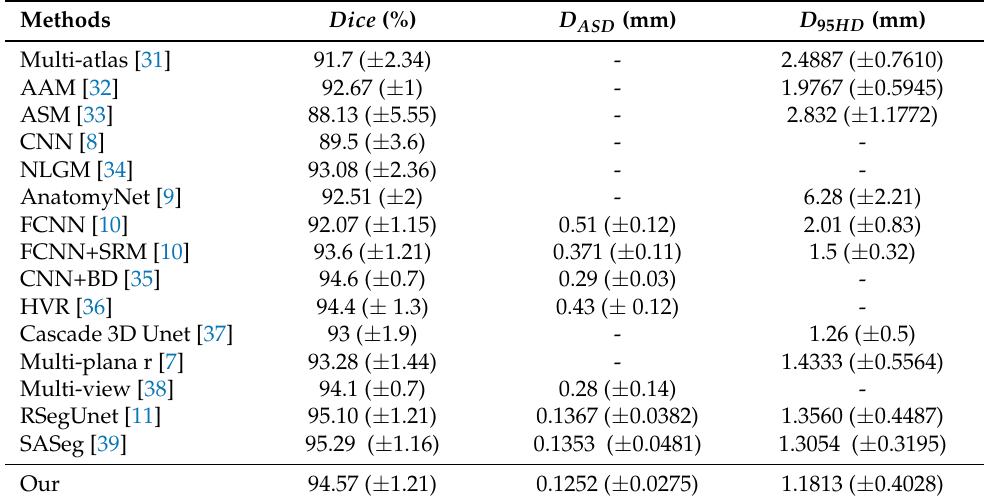
Table 3. Quantitative comparison of segmentation performance for the PDDCA dataset between the proposed method and the state-of-the-art